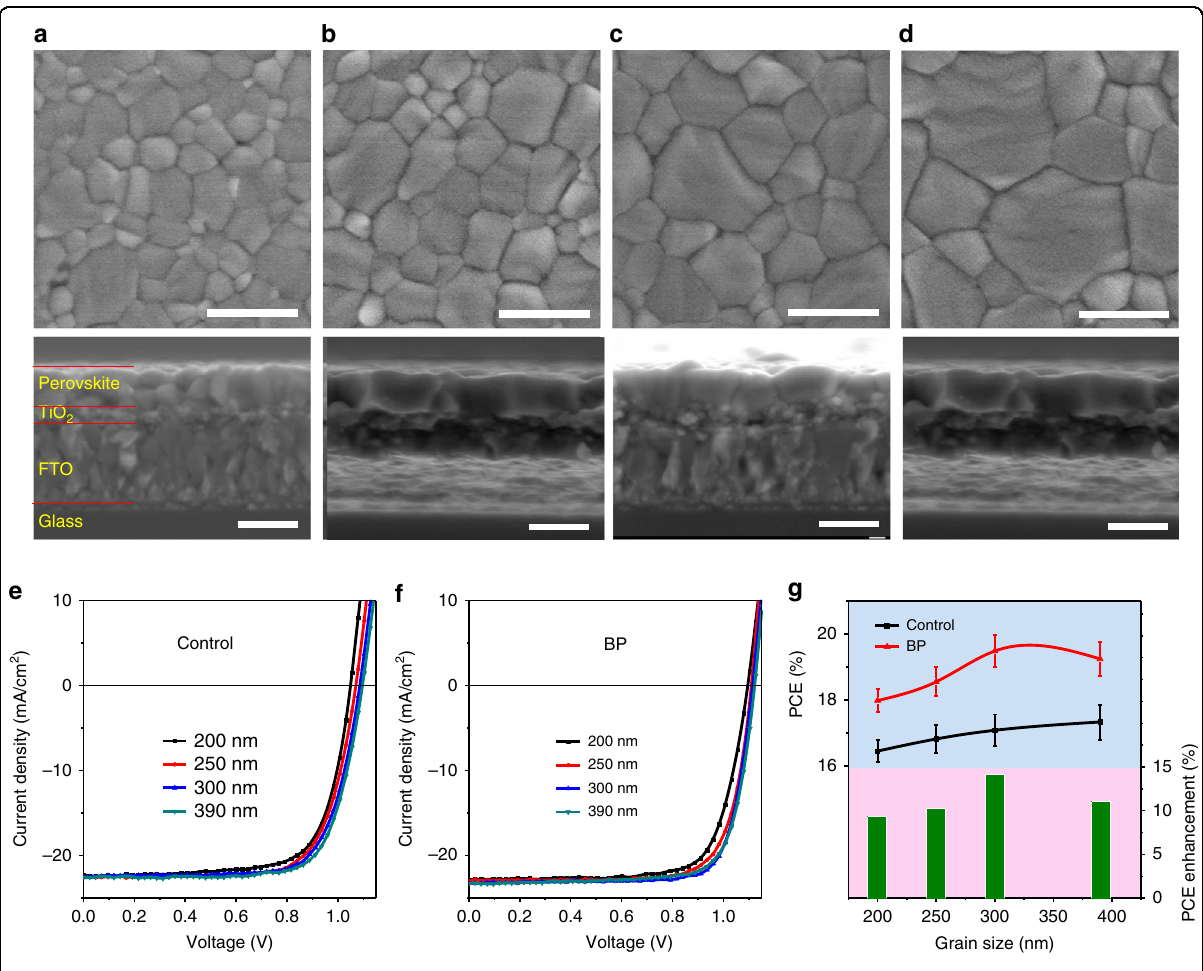
Fig. 4 Grain-size effect of MAPbI 3 perovskite fi lms. a – d Plan view and corresponding cross-sectional view of the scanning electron microscopy (SEM) images of perovskite fi lms with different grain sizes on FTO/TiO 2 substrates. The length of all the scale bars is 500 nm. The average grain sizes of the perovskite fi lms in a – d are 200, 250, 300 and 390 nm, respectively. e , f J – V curves of the PSCs without (control) and with BP (2 coats) deposited on perovskite fi lms. g Average PCEs and relative PCE enhancement (after the BP modi fi cation) of PSCs with different perovskite grain sizes. The black curve (control) and red curve (BP) correspond to the PCEs of devices without and with the BP modi fi cation, respectively, while the green columns represent the relative PCE enhancement after the BP modi fi